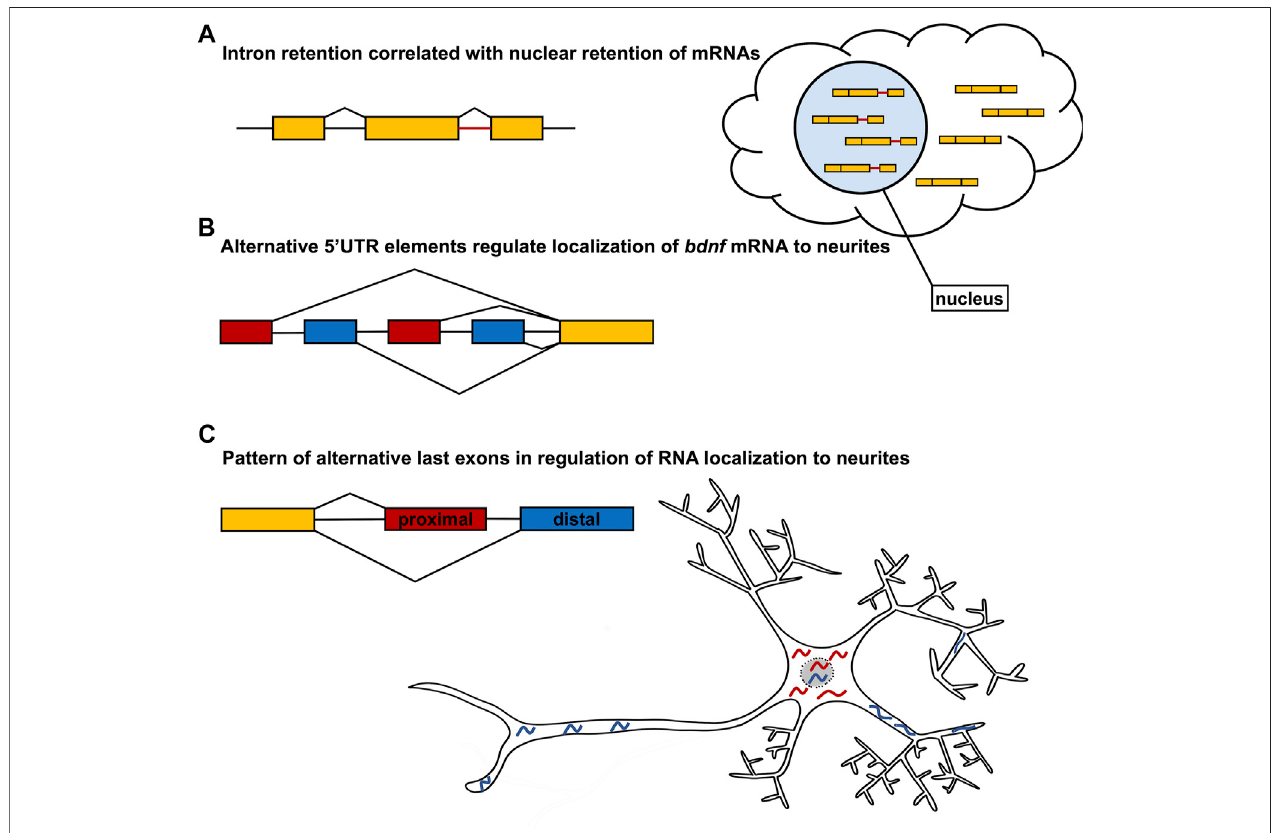
FIGURE 2 | Alternative Splicing regulates mRNA localization. (A) Intron retention has been demonstrated to be one of the most abundant splicing events that regulatesnuclearretentionofmRNA. (B) Alternative fi rstexonswithdistinct5 ′ UTRsequencesregulate bdnf mRNAlocalizationtoneuritesasdemonstratedintheneuron model. The gene model presented does not represent all possible alternative fi rst exons of bdnf , but just the relative positions of the transcripts analyzed in Baj et al. (2011). (C) Large scale analysis of neurite and soma enriched alternative transcripts identi fi es the usage of alternative last exons as being one of the largest contributors to differential localization. More speci fi cally, the use of distal last exons more strongly correlates with neurite localization whereas the use of proximal last exons more strongly correlates with soma localization. An example of this is shown in the neuron